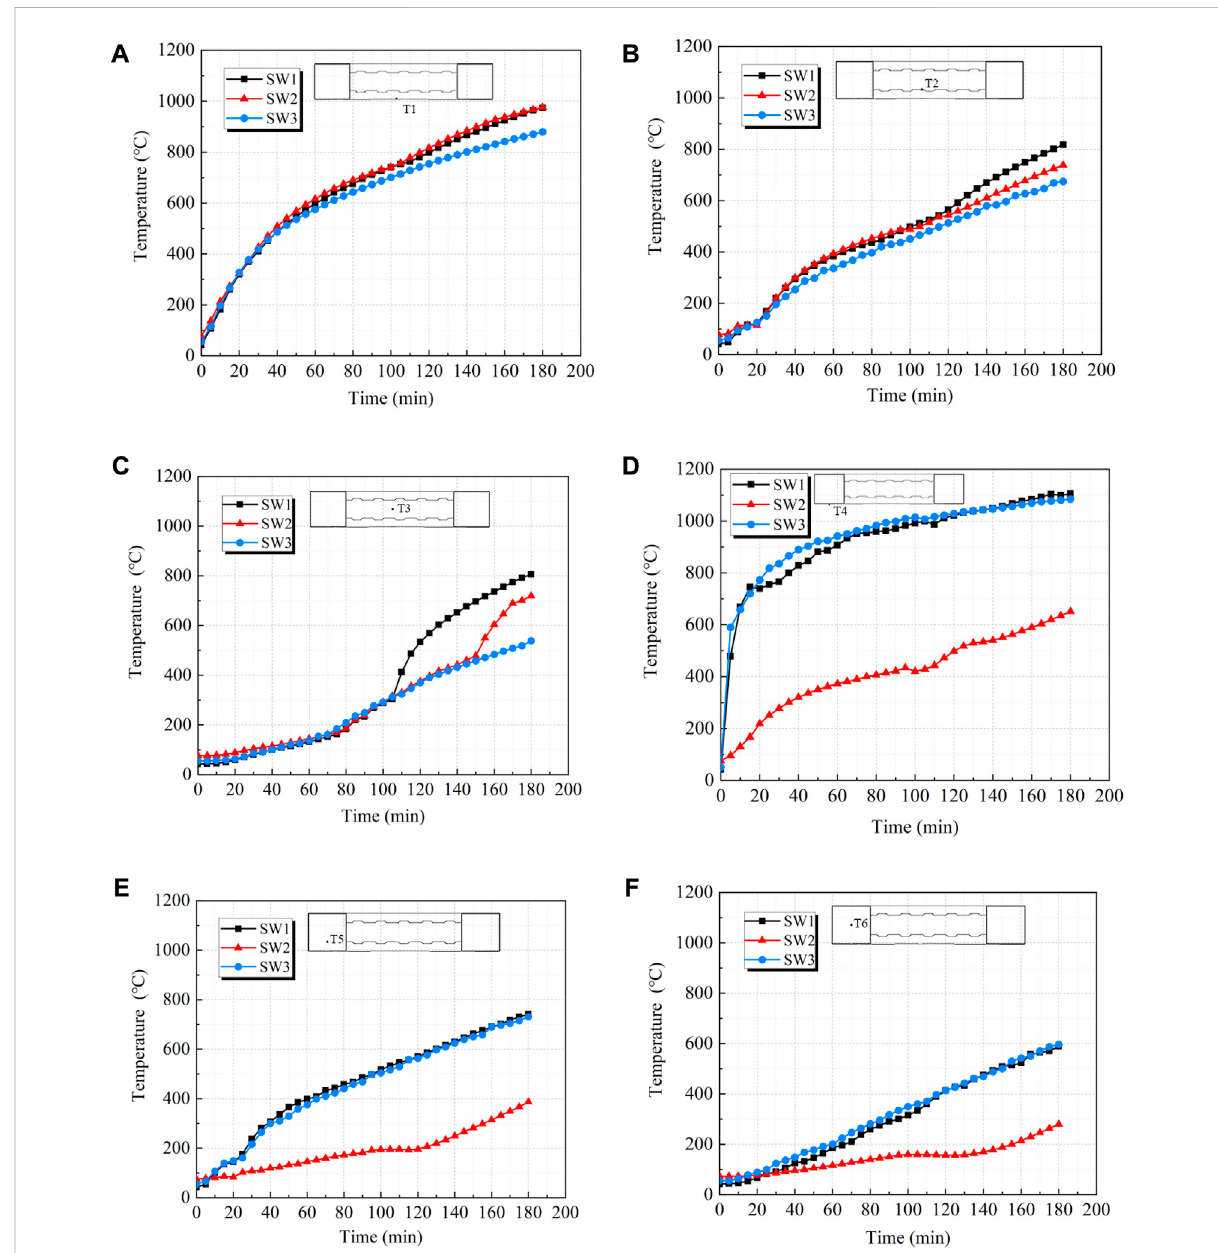
FIGURE 12 Temperature-time curves of different specimens at the same measured point: (A) T1; (B) T2; (C) T3; (D) T4; (E) T5; (F)